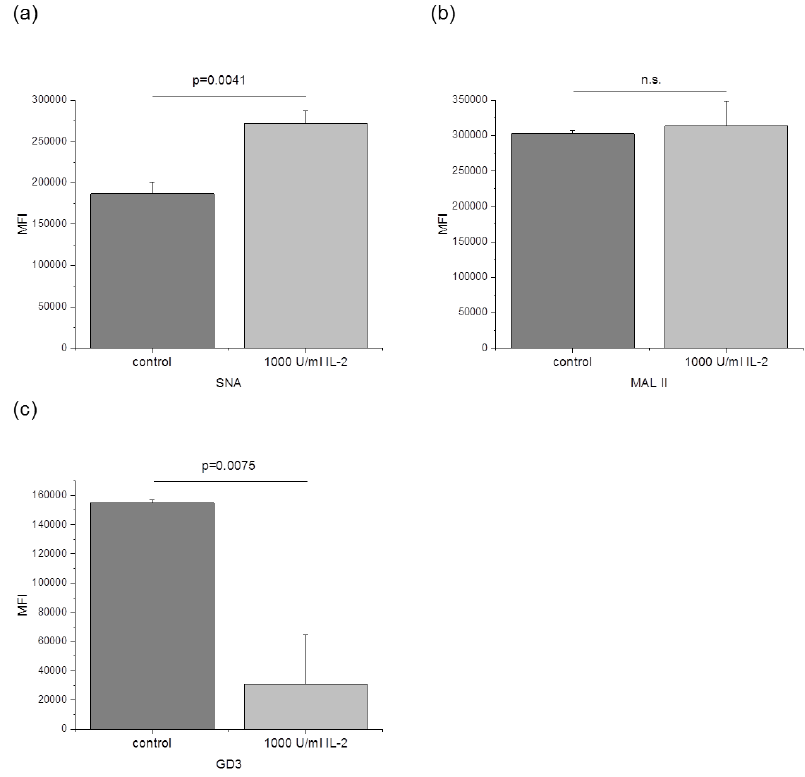
Figure 3. Analysis of NK cell sialylation by flow cytometry. NK-92 cells were incubated without IL-2 for 24 h and analyzed directly (control) or treated with 1000 U / mL IL-2 for additional 24 h.